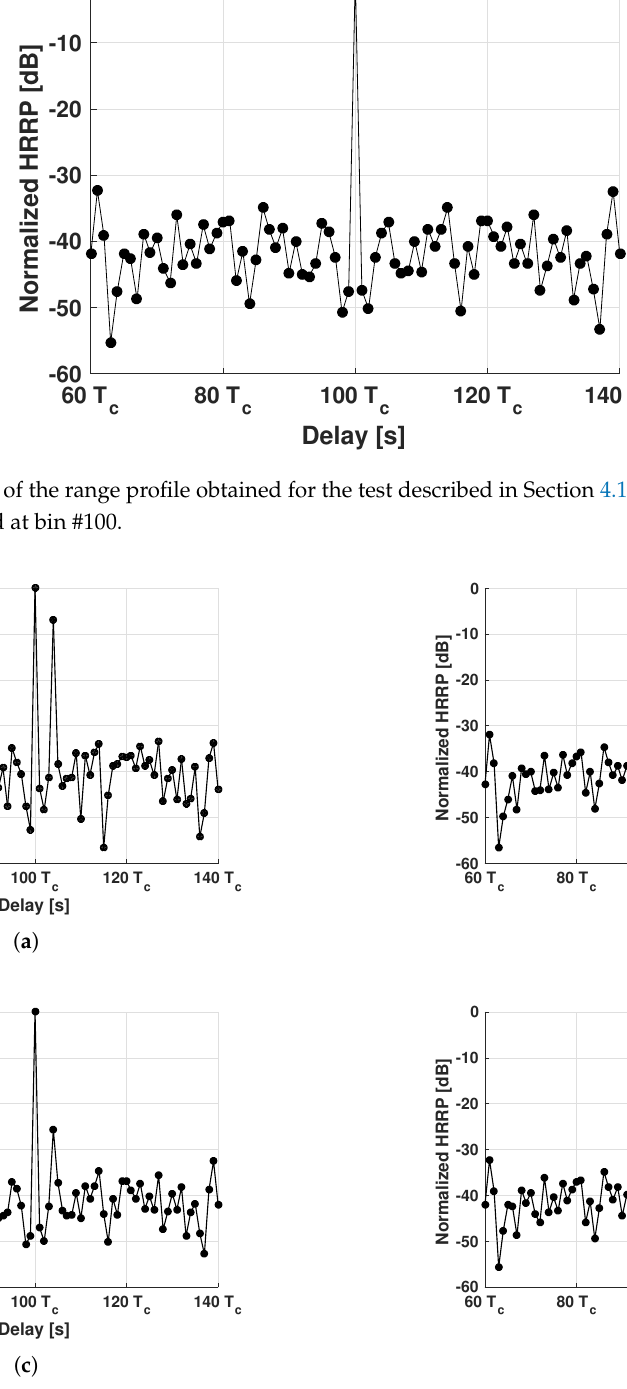
Figure 8. Resulting range profiles obtained for the test described in Section 4.2. They were normalized to the respective peaks, placed at bin #100. The various profiles were obtained considering for the secondary scatterer different attenuations with respect to the main one: 7 dB ( a ); 17 dB ( b ); 27 dB ( c ) and 37 dB ( d